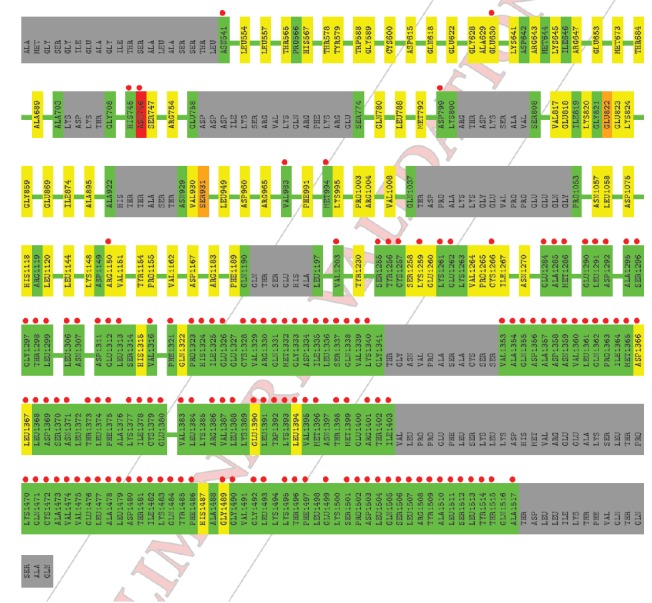
DOI:
http://dx.doi.org/10.7554/eLife.22567.026